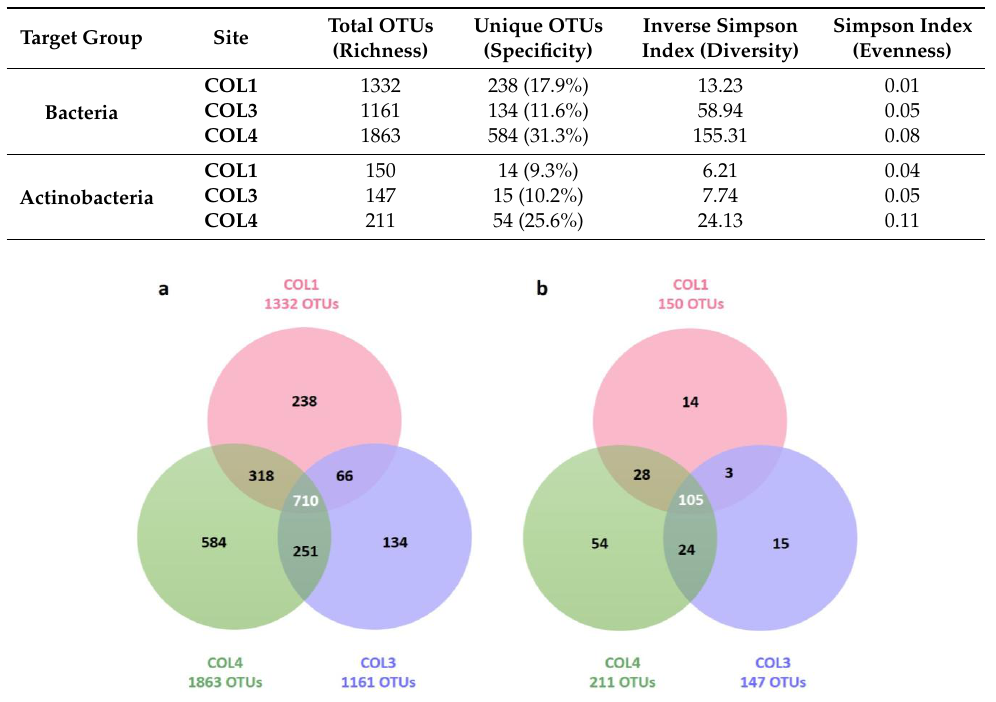
Figure 1. Venn diagrams showing the numbers of shared and unique bacterial ( a ) and actinobacterial ( b ) OTUs between the three moonmilk sampling points (COL1, COL3, COL4). Table 2. Pairwise comparisons of shared OTUs between the moonmilk deposits.